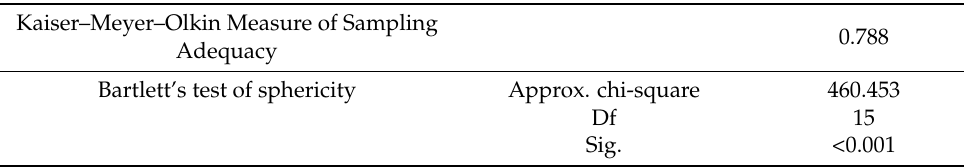
Table 2. KMO and Bartlett’s